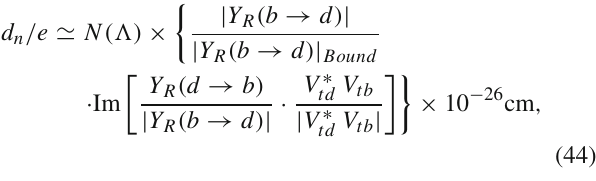
d n / e (cid:8) N ((cid:2))